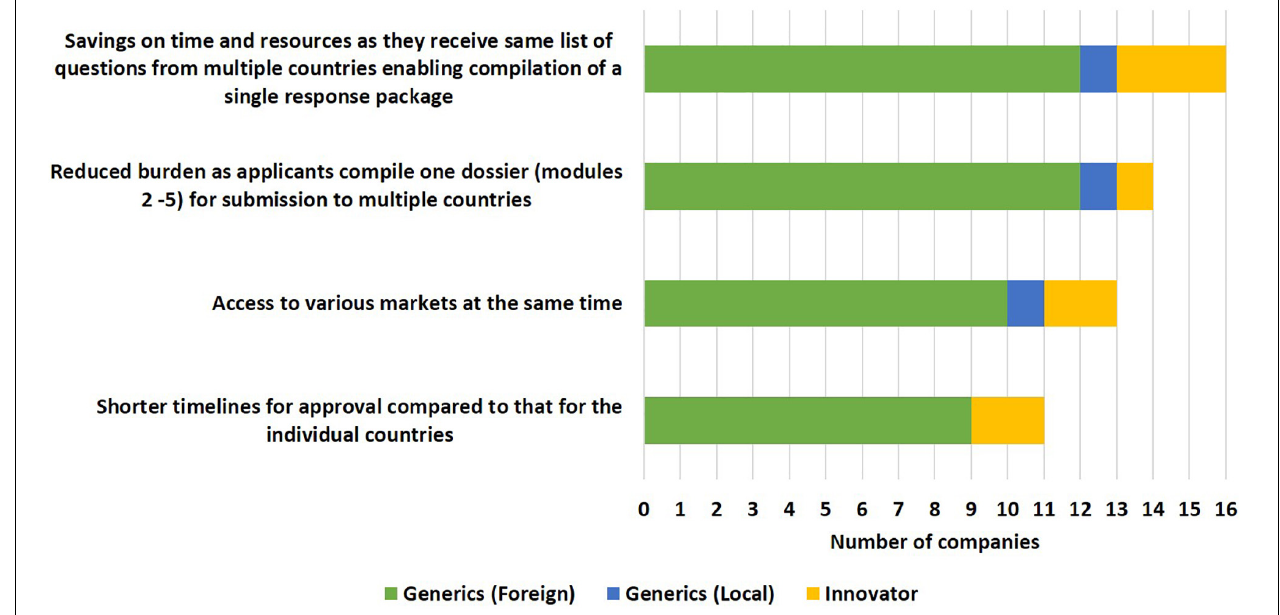
FIGURE 3 | Benefits of the ZaZiBoNa initiative to applicants according to pharmaceutical industry respondents.